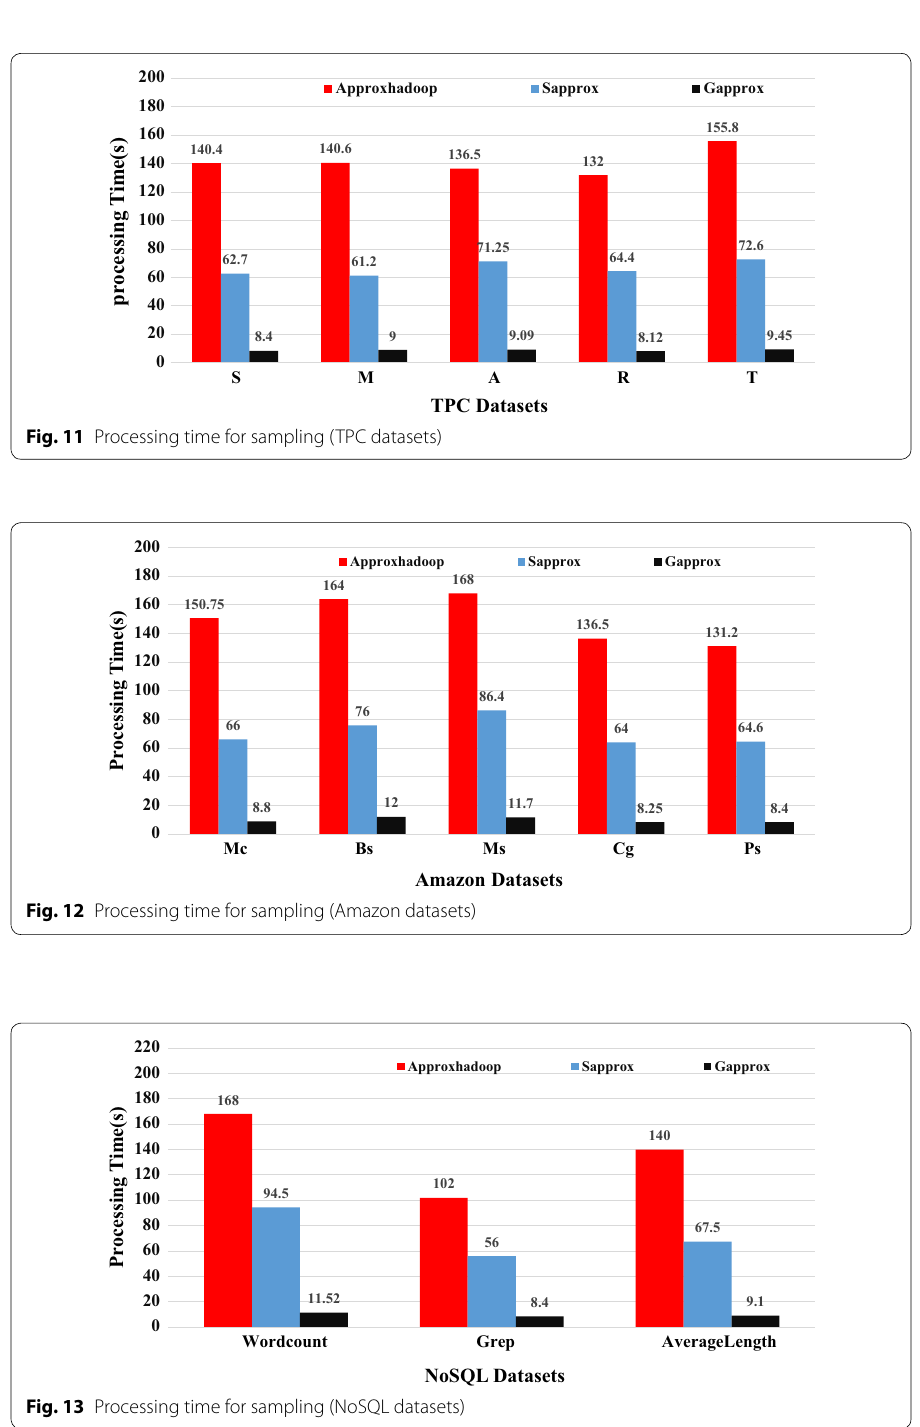
In Figs. 11, 12, and 13, processing time (in seconds) is presented as the vertical axis and the horizontal axis shows the datasets. Our approach can reduce the time of pro- cessing as these figures show.